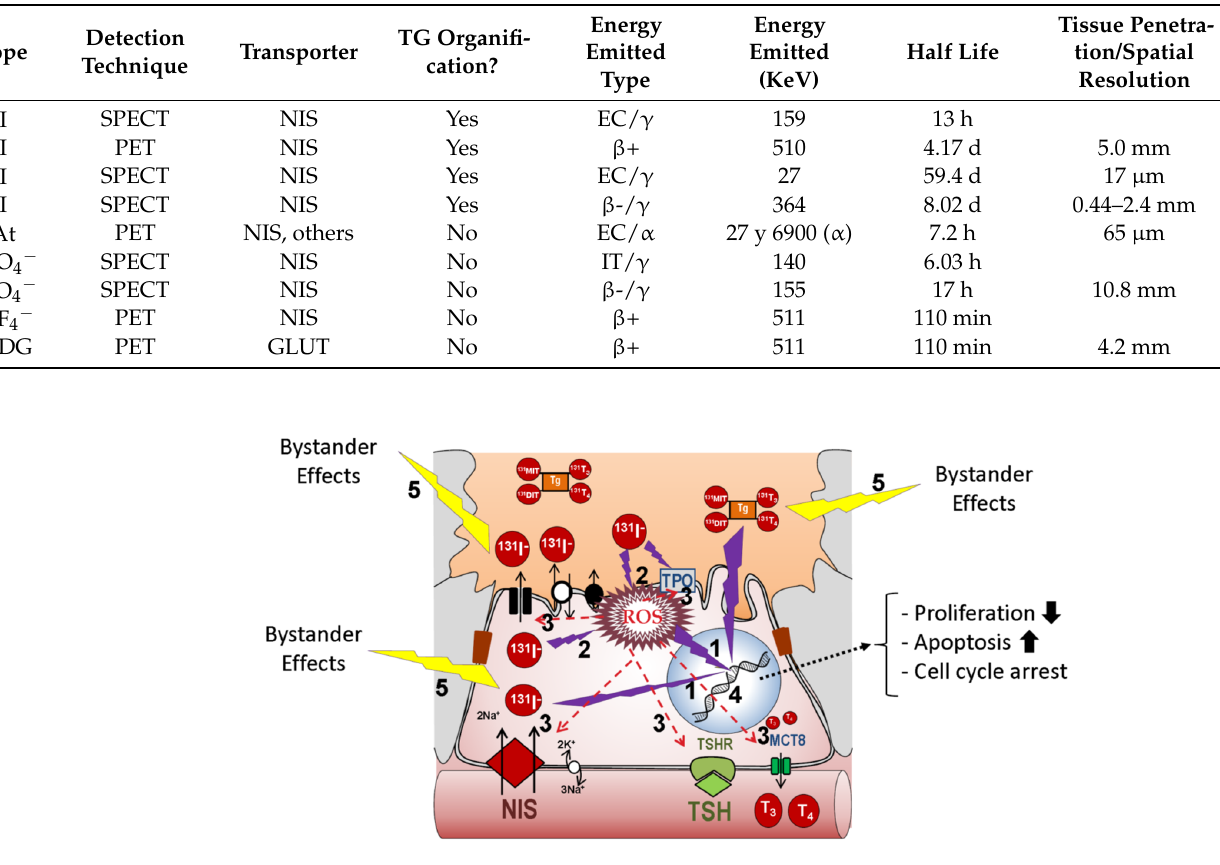
Figure 1. Putative effects of radio-iodide in the cell. Two types of effects can be experienced: direct and indirect. Four main types of damage can occur as a result of direct effects: (1) direct DNA damage such as single-strand and double-strand breaks, (2) increased ROS, (3) inactivation of DNA repair proteins to compensate for elevated ROS, (4) elevated ROS-mediated protein inactivation of proteins directly implicated in iodide transport, such as NIS, or in general thyroid differentiation (TPO, Tg, Duox2, TSH-R, Pendrin, etc.). Indirect non-targeted effects of radiation (5) occur in the surrounding cells as a result of bystander and abscopal effects. In any case, damage intensity would depend on radioiodine concentration and subcellular localization. Abbreviations: NIS: sodium/iodide symporter; TPO: thyroid peroxidase; Tg: thyroglobulin; TSH-R: Thyroid Stimulating Hormone receptor; ROS: Table 1. Radioactive isotopes used in clinical medicine for thyroid cancer. 18 F-FDG: 2-deoxy-2-[18F]-Fluor-D-glucose; 18 F- BF4-: [18F]-tetrafluoroborate; EC: electronic capture; γ: gamma radiation (high energy photons); β+: positrons from the nucleus; β-: electrons from the nucleus; IT: isometric transition; PET: positron emission tomography; SPECT: single-photon emission computed tomography; TG: thyroglobulin; GLUT: Glucose Transporter. Tissue Transporter TG Organification? Energy Emitted Type Energy Emitted (KeV) Penetration/Spatial Resolution 123 I